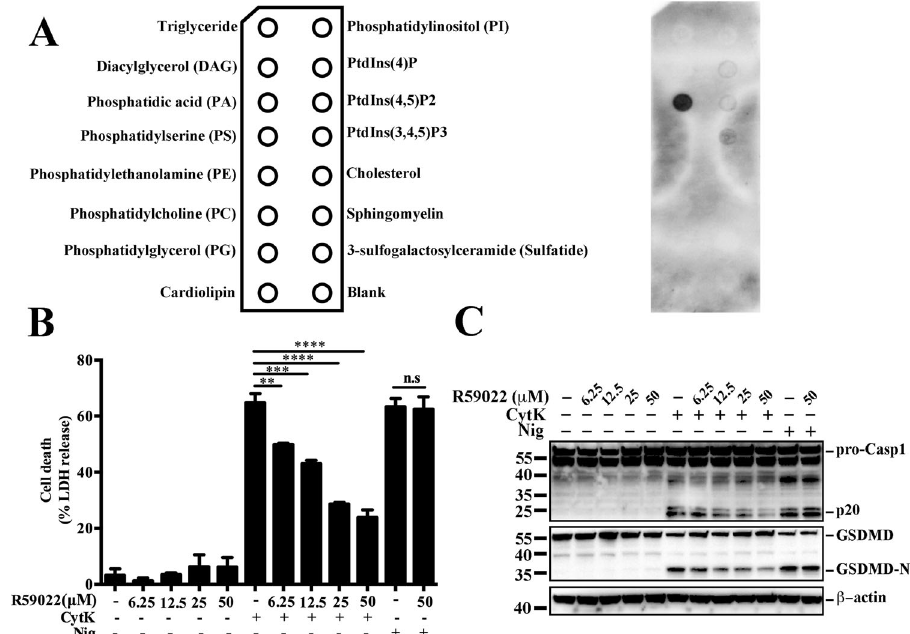
Fig. 6 Phosphatidic acid (PA) binds to CytK and is necessary for CytK-induced pyroptosis. A A membrane lipid strip pre-coated with indicated lipids (left) were incubated with CytK and then probed with anti-His antibody (right). B , C dTHP-1 cells were pretreated with or without ( − ) an increasing dose of R59022 for 6 h, and then treated with or without ( − ) CytK (500 nM) or nigericin (Nig, 20 μ M) for 1 h. LDH release in the cellular supernatants was determined ( B ). The supernatant together with the corresponding cell lysate were blotted with antibodies against Casp1, GSDMD, or β -actin (loading control) ( C quantify the fl uorescence. The obtained fl uorescence intensities were normalized to time = 0 to determine the fold increase in intensity.